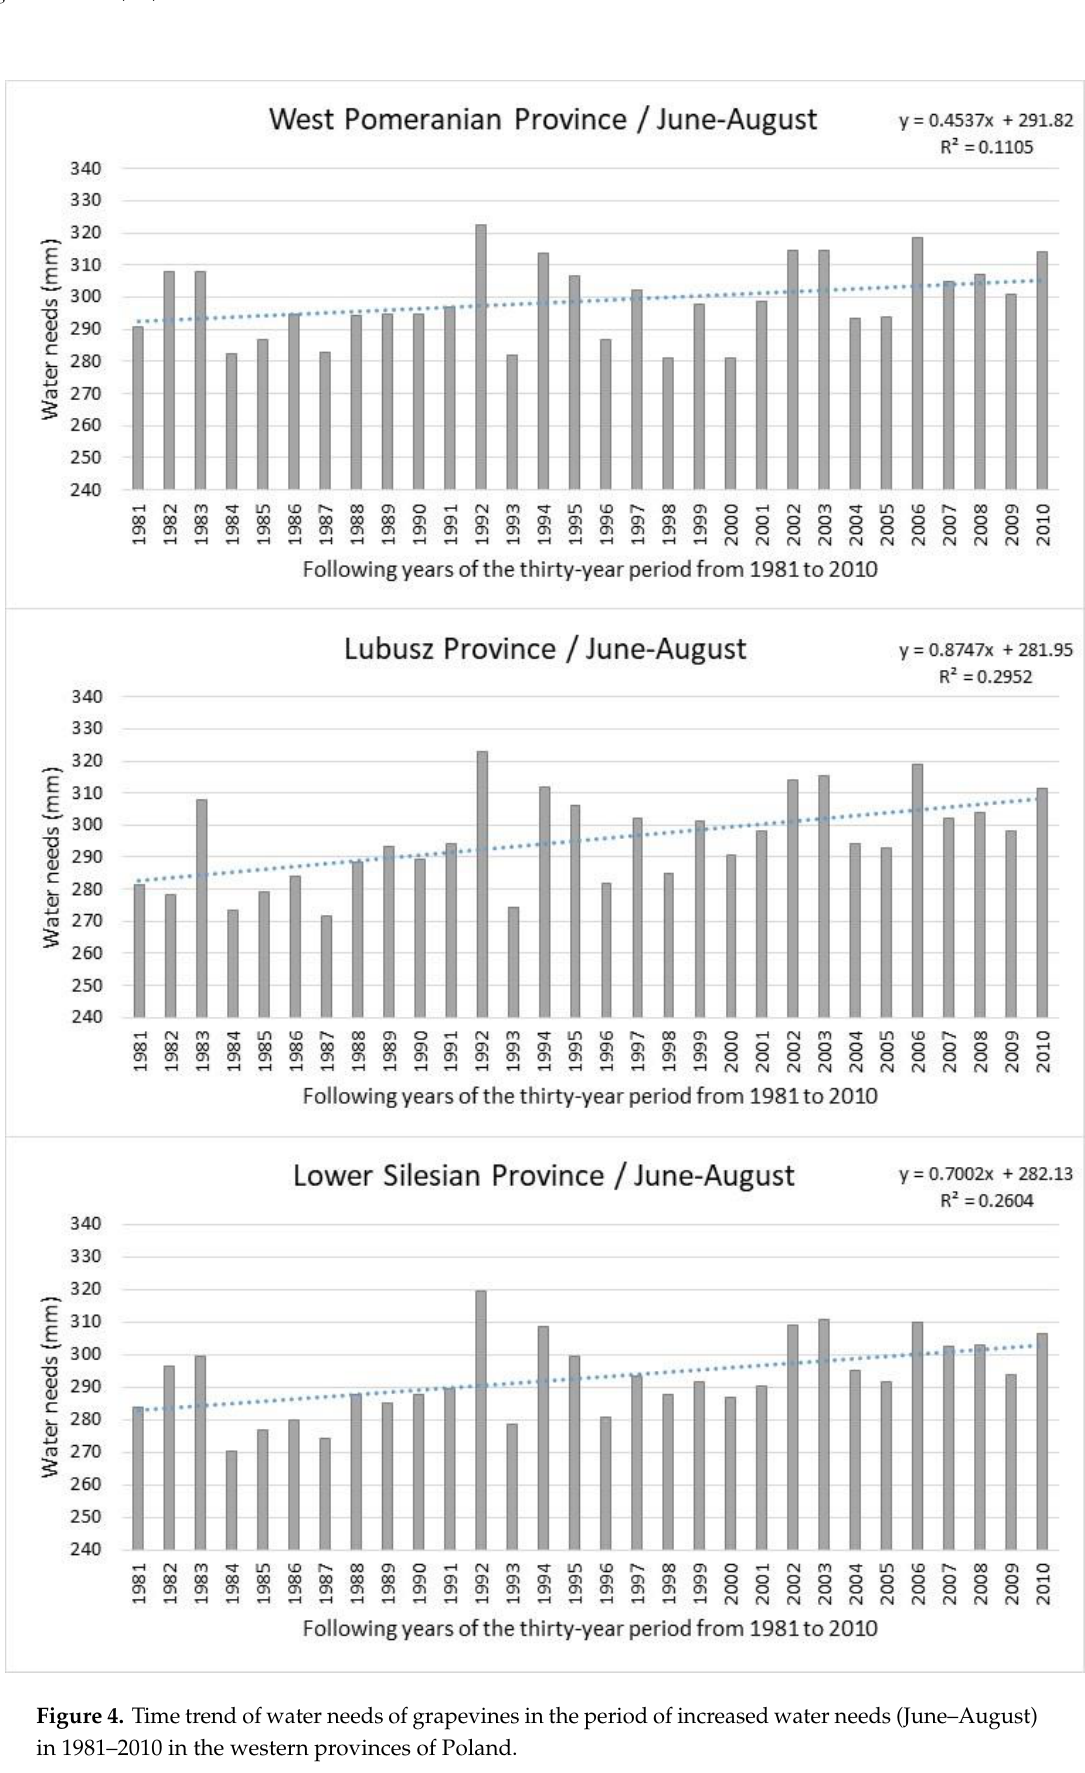
Figure 4. Time trend of water needs of grapevines in the period of increased water needs (June–August) in 1981–2010 in the western provinces of Poland.